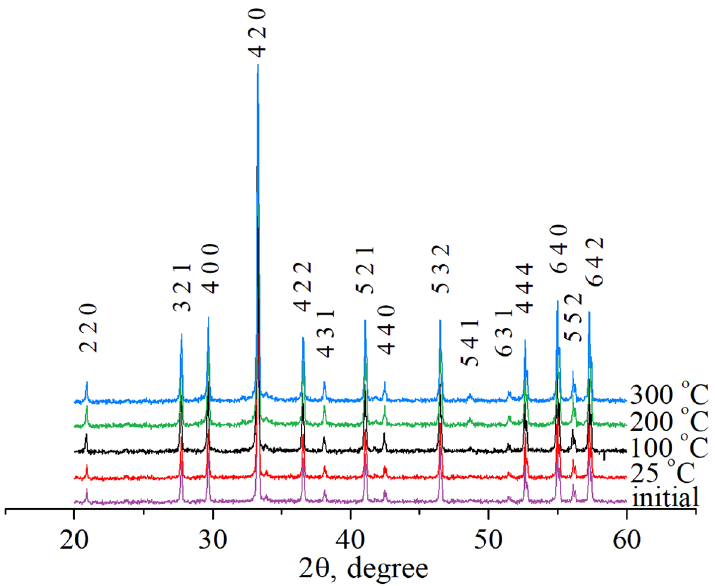
Figure 2. XRD curves for ceramics Y 2.5 Nd 0.5 Al 5 O 12 before (initial) and after leaching. The study of the microstructure of the samples after the leaching tests has shown the test temperature to affect the nature of the surface destruction significantly. At “low” test temperatures (25 and 100 °C), a destruction of the surface near the pores is observed (Figure 3a, b). Some light deposits were observed on the surface of the samples. Most likely, these ones were formed as a result of the interaction of the test environment with the materials of the autoclave. Holding in distilled water at a 200 °C for 1000 h led to a drastic increase in the etching intensity of the sample surface (Figure 3c). It is important to note that the destruction areas on the sample surface were arranged along the grain boundaries (in Figure 3c, such an area is framed by a yellow dashed rectangle).